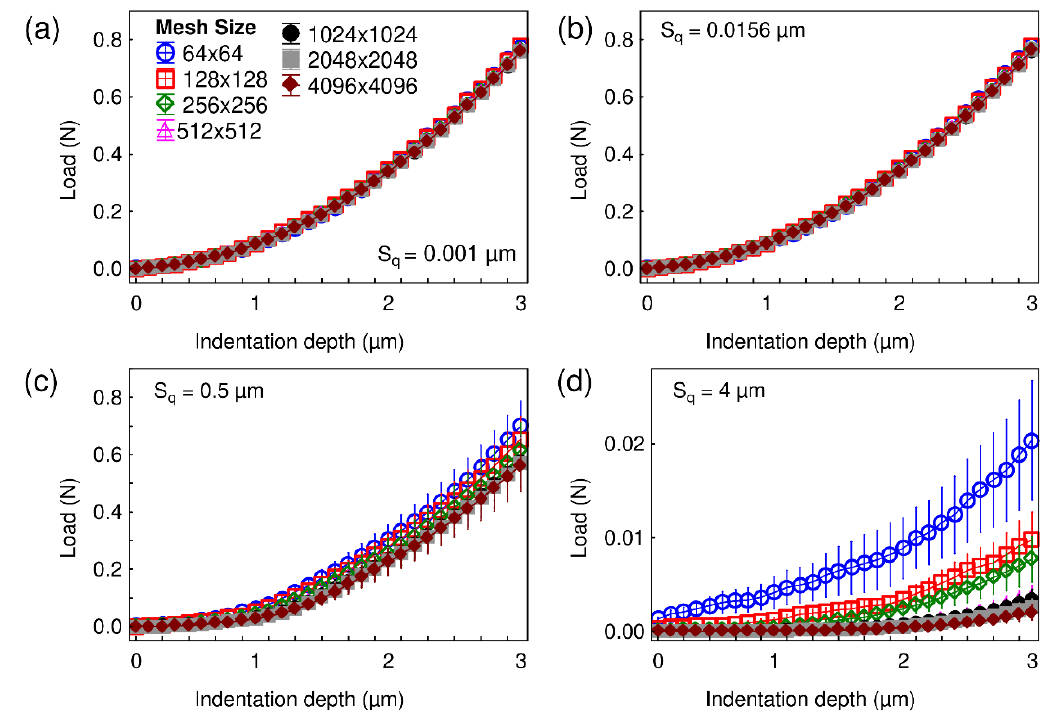
Figure 3. Load-indentation depth curves obtained for different mesh sizes with a root-mean-square roughness S q equal to ( a ) 0.001 µ m, ( b ) 0.0156 µ m, ( c ) 0.5 µ m, and ( d ) 4 µ m. The wavelength and fractal dimension of the tested surfaces are, respectively, set to 32 µ m and 2.5.